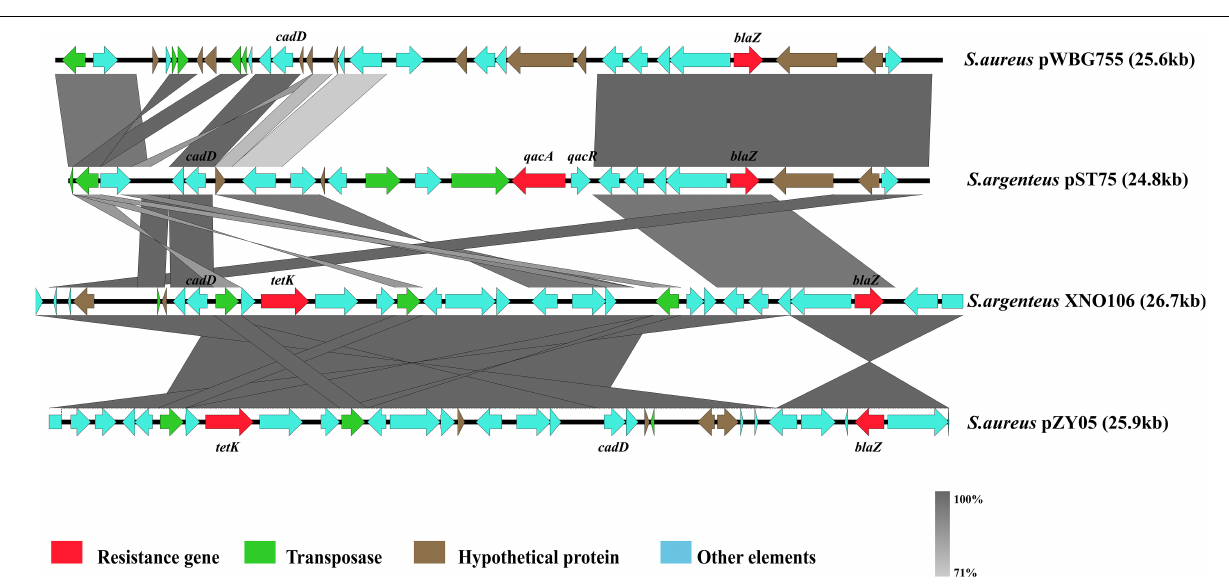
Frontiers in Microbiology |